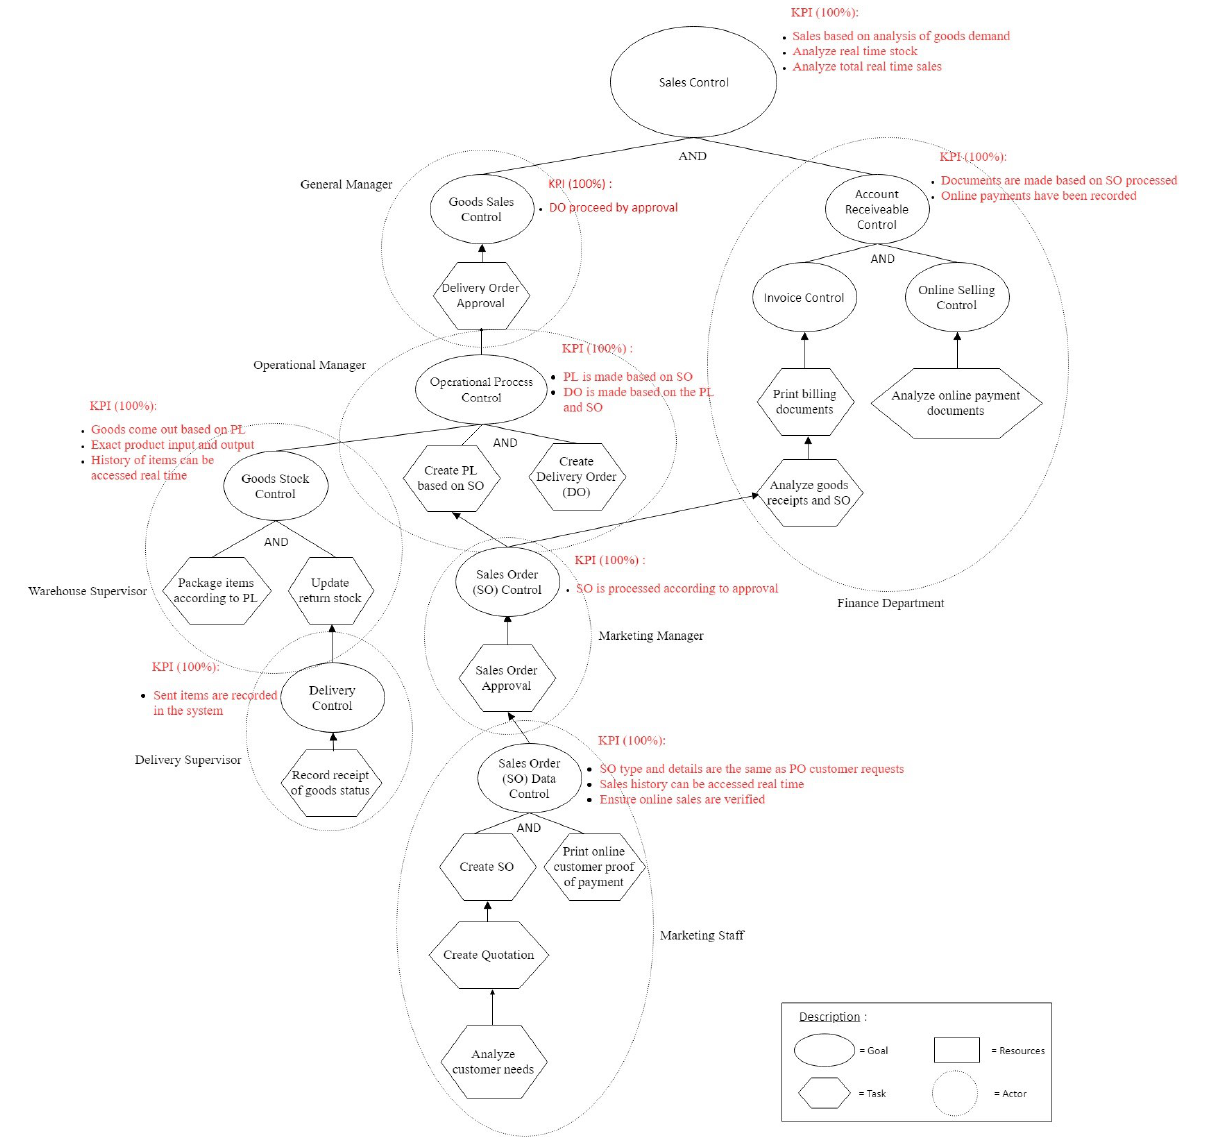
Figure 3: Improved GTM of Sales